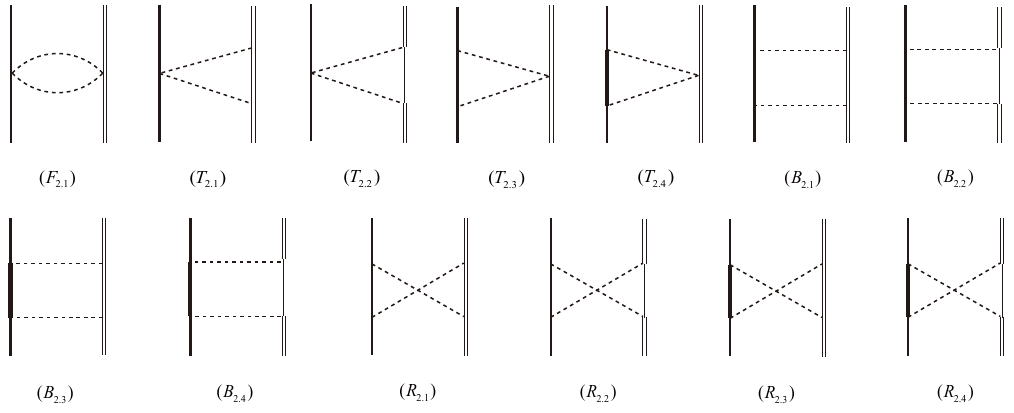
Figure 5 . The two-pion-exchange diagrams of the (cid:6) c (cid:22) D (cid:3) system at O ( (cid:15) 2 ). The internal heavy baryon lines in diagrams ( T 2 : 3 ), ( B 2 : 1 ), ( B 2 : 2 ), ( R 2 : 1 ) and ( R 2 : 2 ) can also be the (cid:3) c . The notations are the same as those in (cid:12)gure 2.